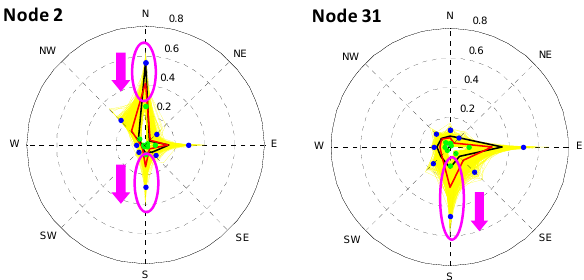
Figure 4. Trend quantification of annual sector frequency (Nodes 2 and 31, see Figure 1). Black line: annual mean frequency 1958-2001. Red line: annual mean predicted frequency (2050). Yellow lines: bootstrapped samples (2050). Yellow and Green dots: 95% confidence intervals (2050).